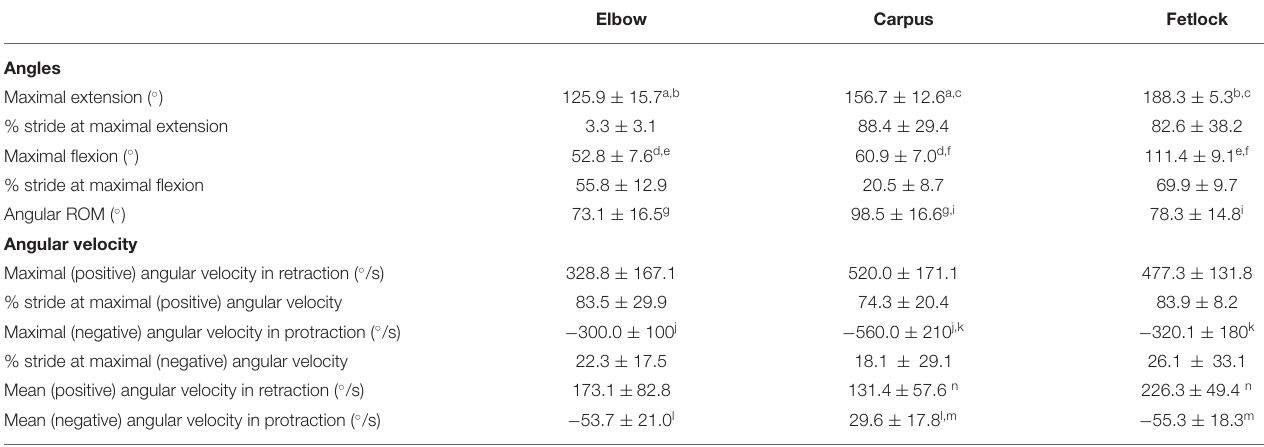
TABLE 2 | Joint angle parameters in horses during swimming ( n = 10).